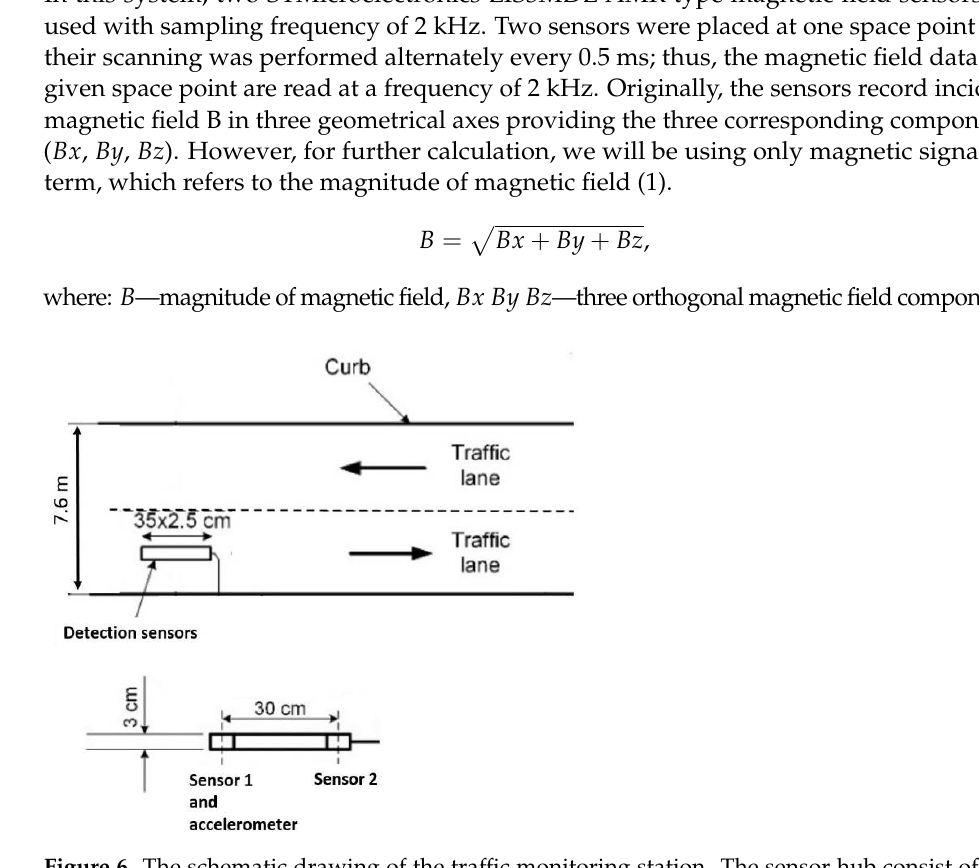
Figure 6. The schematic drawing of the traffic monitoring station. The sensor hub consist of two magnetic field sensors spaced by 30 cm and one accelerometer.